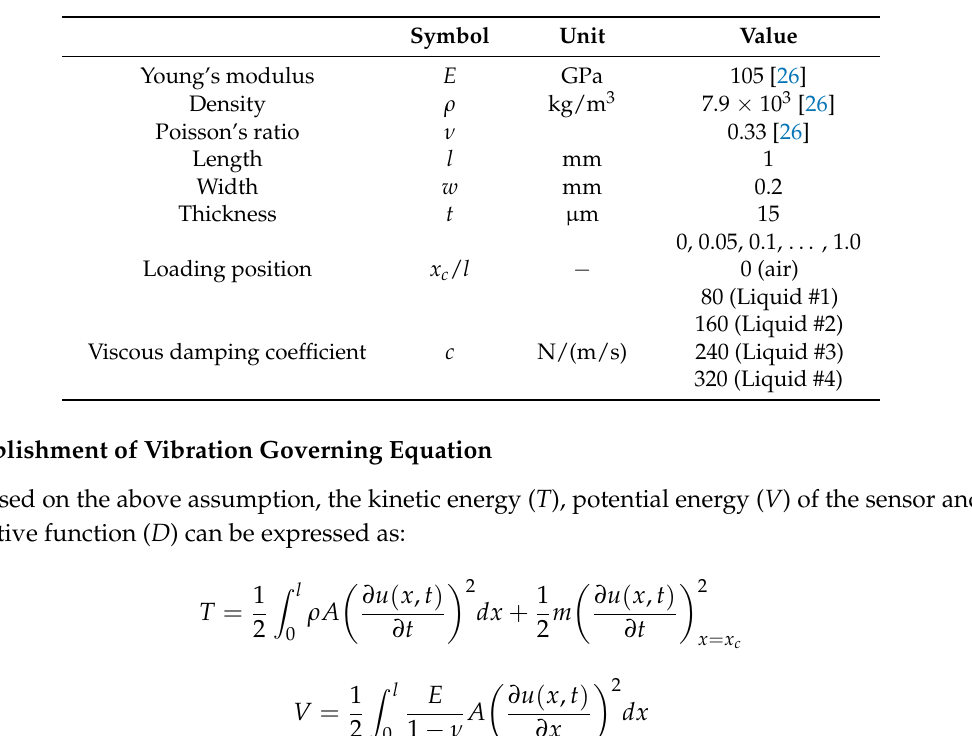
Table 1. Information for the sensor, liquid, and loading conditions in this